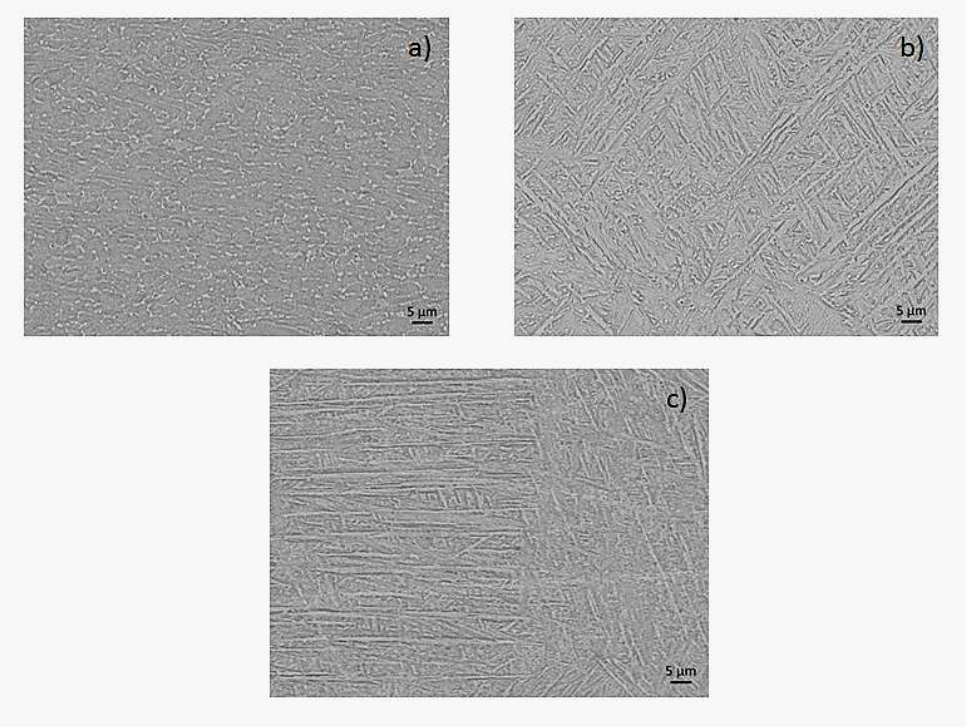
Figure 2. SEM observations in the XZ plane of ( a ) Ti-6Al-4V Wr, ( b ) EBM-MP and ( c ) DMLS-MP specimens.